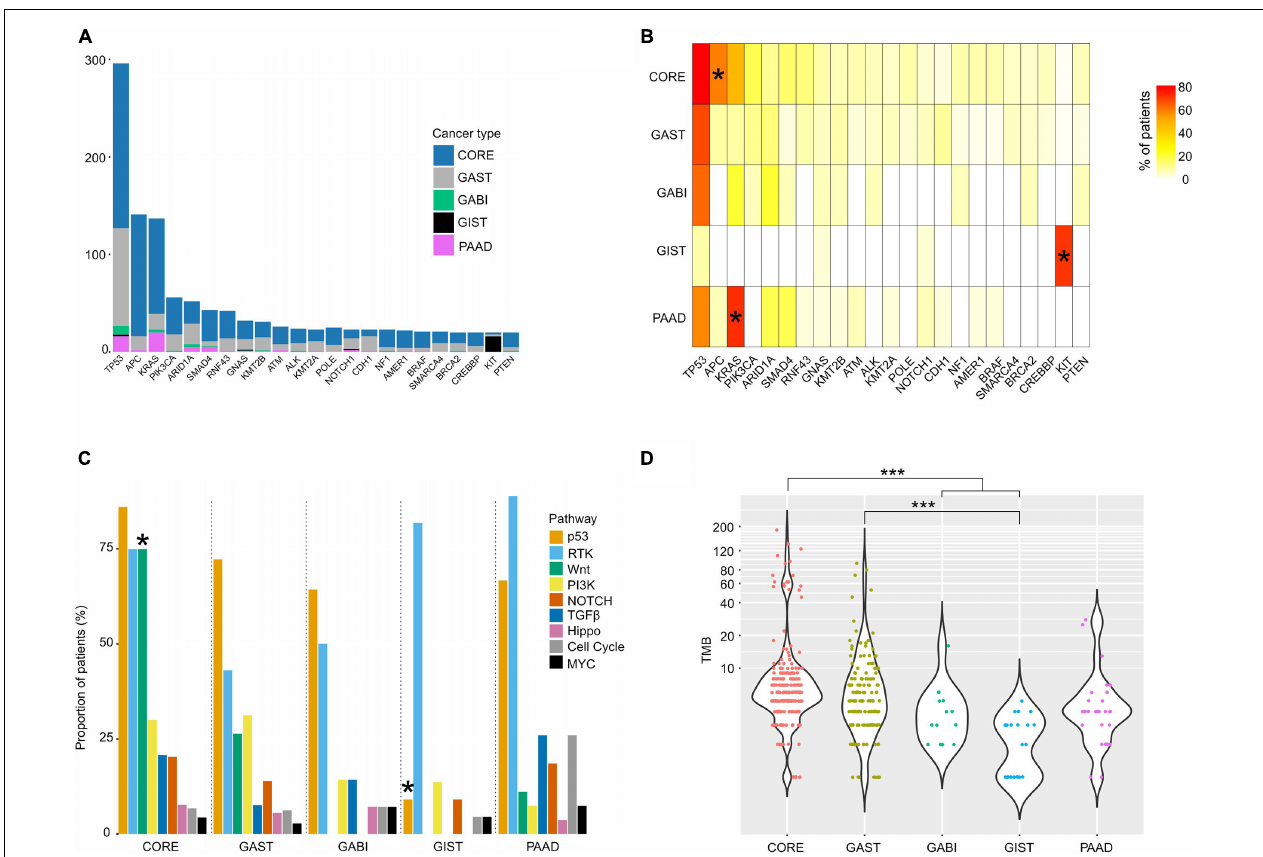
FIGURE 1 | Somatic mutations of different GI cancers. (A) Bar graph showing the patient composition of commonly mutated genes. (B) The mutation frequency of the top mutated genes in each tumor. (C) The proportion of patients with mutations in each pathway. (D) TMB distribution of each cancer. For (B,C) , pairwise comparisons were conducted between every two groups using the Fisher’s exact test. FDR was used for p -value corrections. For (D) , one-way ANOVA on ranks test was used to compare all groups, and the Dunn’s test was used for post hoc analyses. * p < 0.05; *** p <